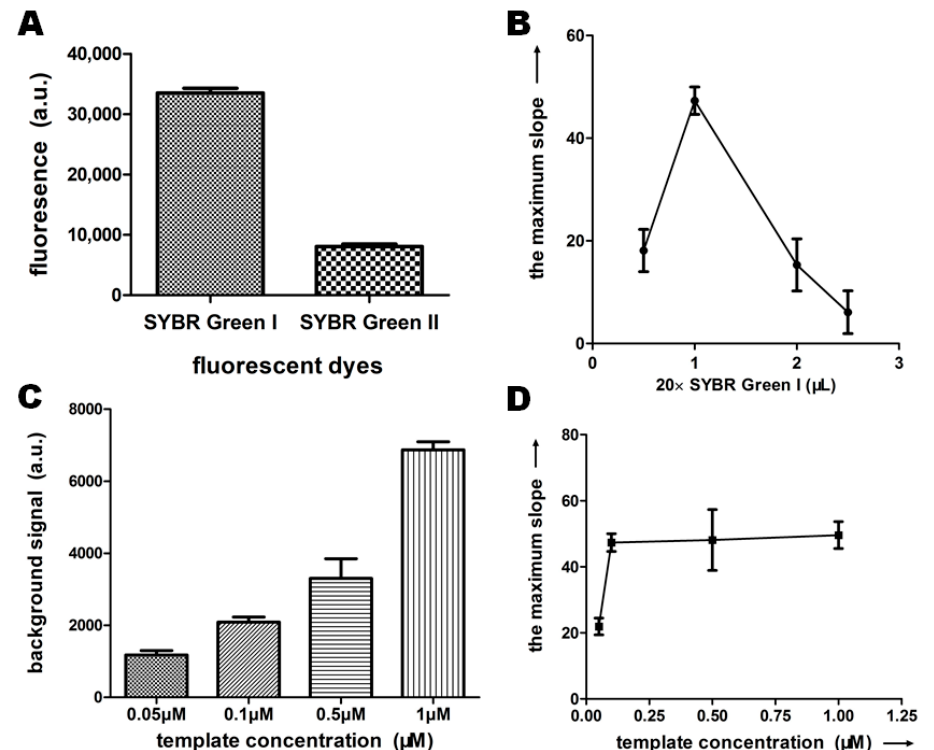
Figure 3. Effect of fluorescent dyes and template quantity on EXPAR. ( A , B ) 1 µ L of 20 × SYBR Green I was adopted as the optimal amount for the subsequent EXPAR; ( C , D ) 0.1 µ M template was used as the optimum template concentration in 20 µ L reaction volume.